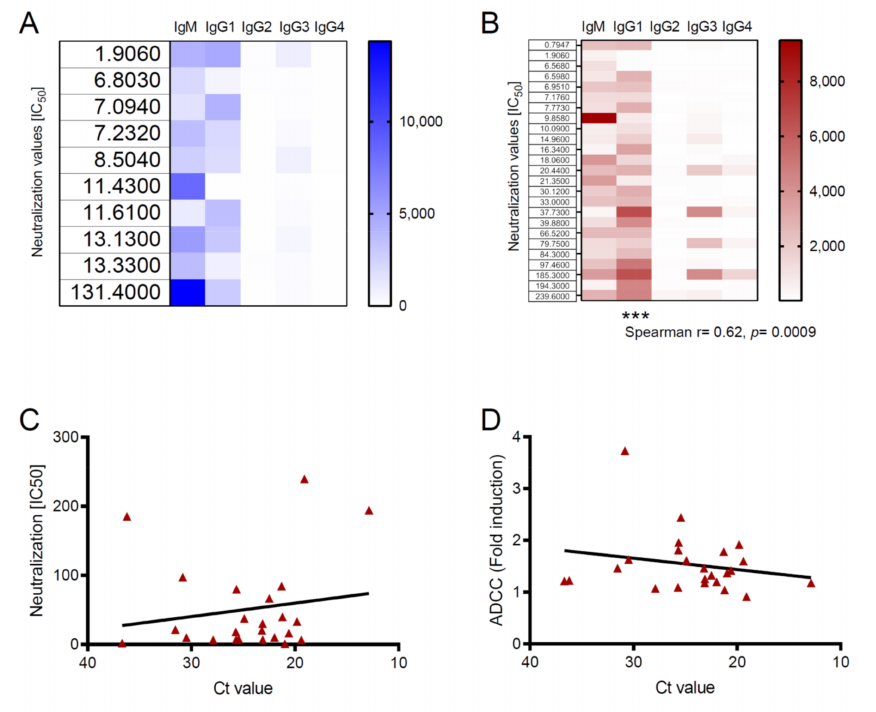
Figure 2. Correlation analysis. Spearman correlation analysis between the plaque reduction neutralization assay (PRNA) values and Ig subclass in vaccine recipients ( A ) and EVD survivors ( B ). Significance is depicted as *** p ≤ 0.001. ( C , D ) Spearman correlation analysis between PCR C t values and neutralization values ( C ) or ADCC fold induction ( D ) in individual EVD survivors. Lines represent linear